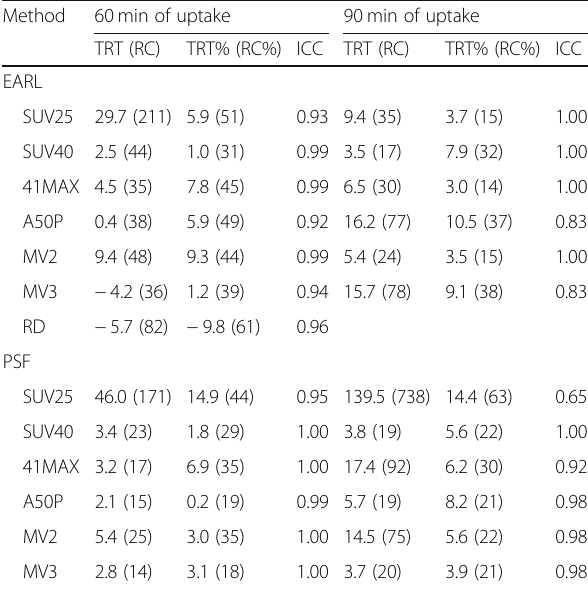
Table 4 Total metabolic active tumour volume repeatability for different tracer uptake intervals, reconstruction settings, and lesion delineation